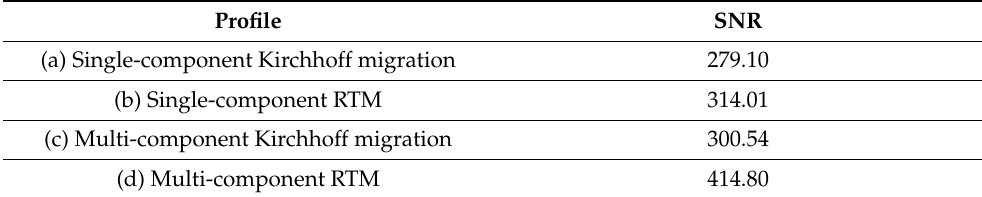
Table 2. SNR of the migration results of the measured